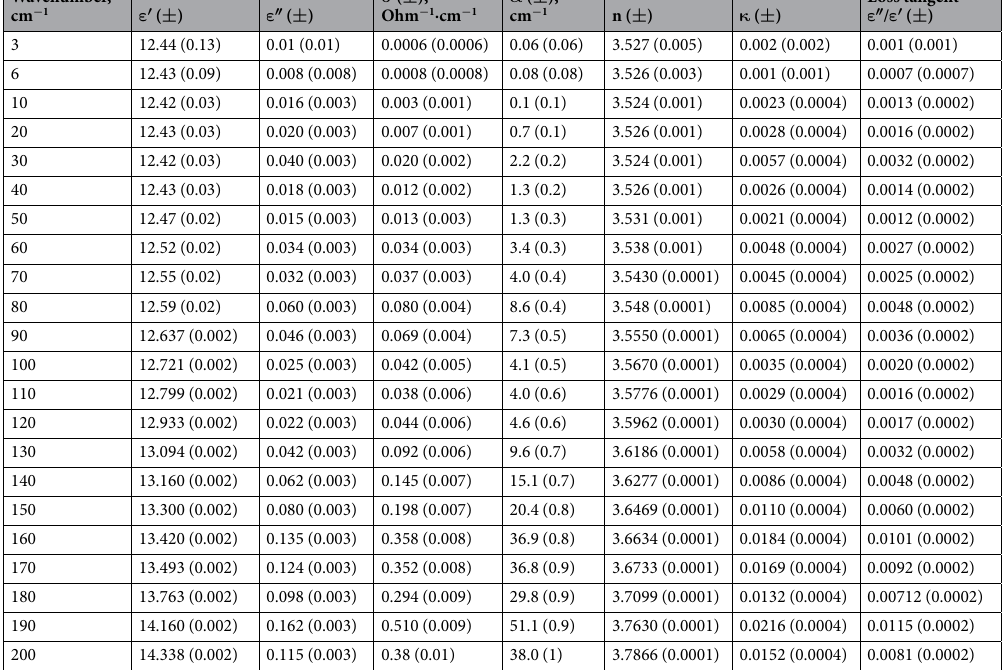
Table 2. Dielectric parameters of the measured SI InP:Fe crystals at selected frequencies.